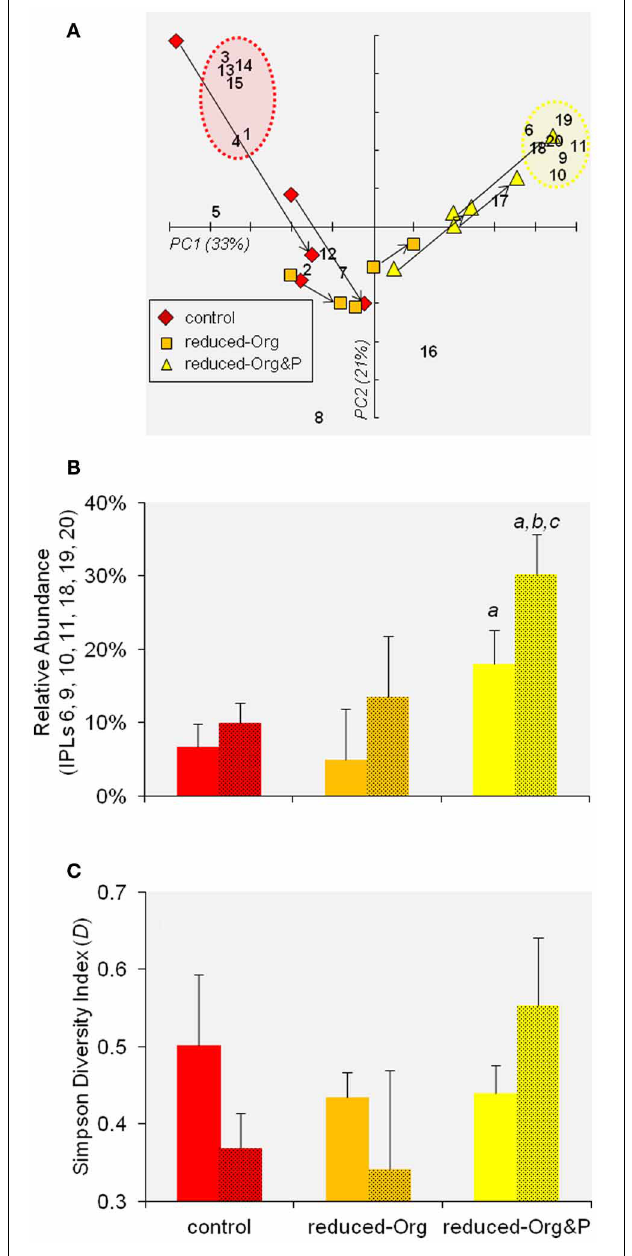
FIGURE 7 | PCA of IPL distributions. (A) Biplot of PC1 and PC2 of IPL distributions in T. kodakarensis . The numbers refer to individual IPLs as described in Table 2 . The arrows indicate the progression of cells from exponential to stationary phase within individual bioreactors. The red and yellow circles identify the clusters of IPLs that were relatively enriched in control or reduced-Org&P cells, respectively (refer to Section IPL Composition and Diversity). (B) The sum of the relative abundance of IPLs identified by the yellow circle in (A) are compared for cells harvested from various culture media at exponential (not shaded) and stationary (shaded) phases. The error bars represent standard deviation and the a, b , and c symbols represent significant differences ( p < 0 . 05) relative to corresponding averages for control, reduced-Org media, and exponential harvests, respectively. (C) The average Simpson Diversity Index of T. kodakarensis IPLs harvested from the various culture media at exponential and stationary phases (as above); error bars represent standard